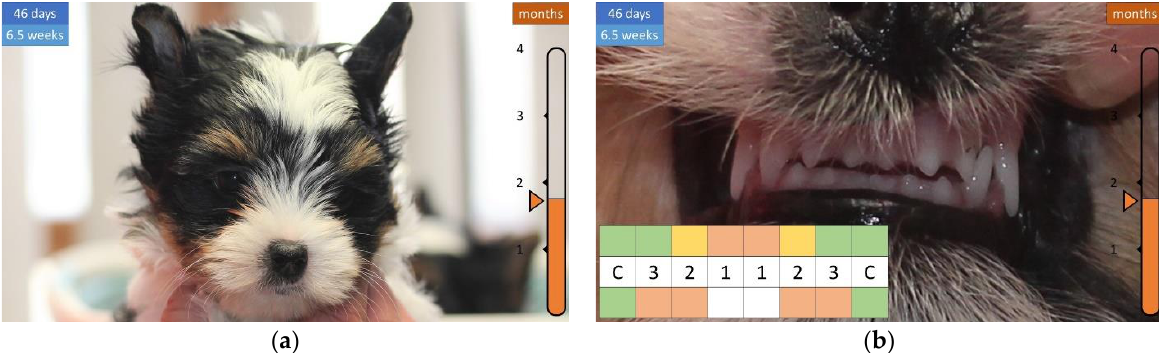
Figure 6. Development of the skull and teeth in a 6-week-old puppy. ( a ) Head shape is no longer spherical. ( b ) Upper dentition completed.